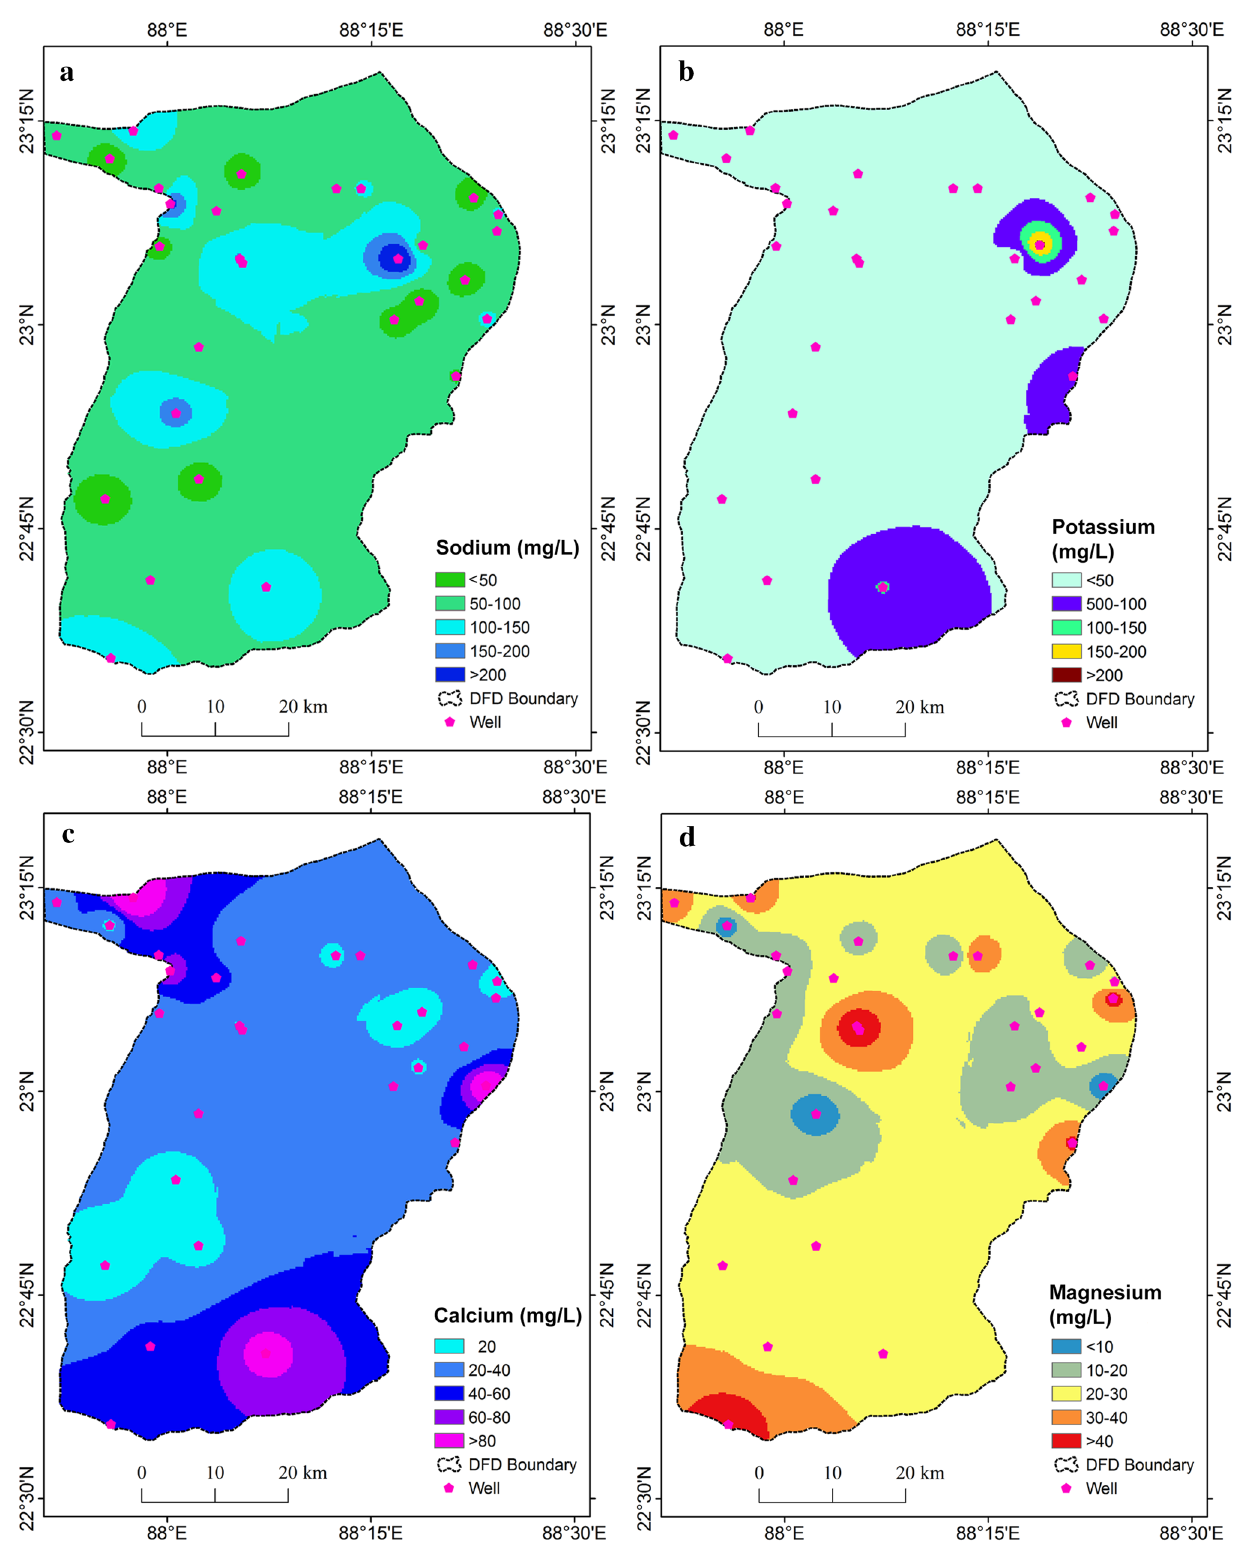
Fig. 6 Spatial distribution of major cations a sodium, b potassium, c calcium, and d